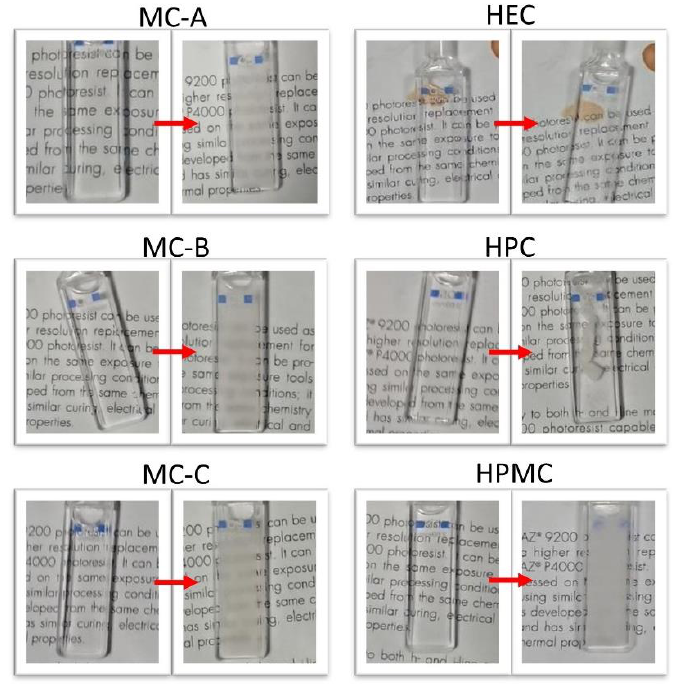
Figure 2. Visual screening of cellulose ethers before and after heating.